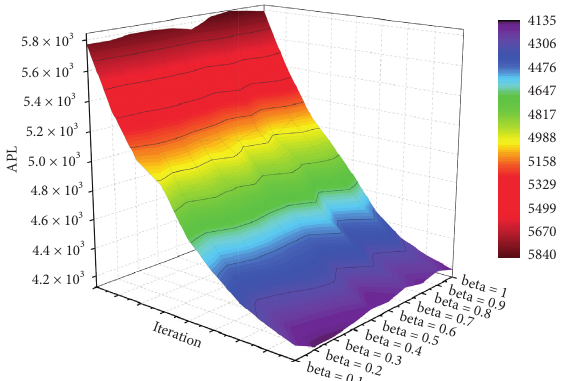
Figure 13: The change trends of APL with different beta values.